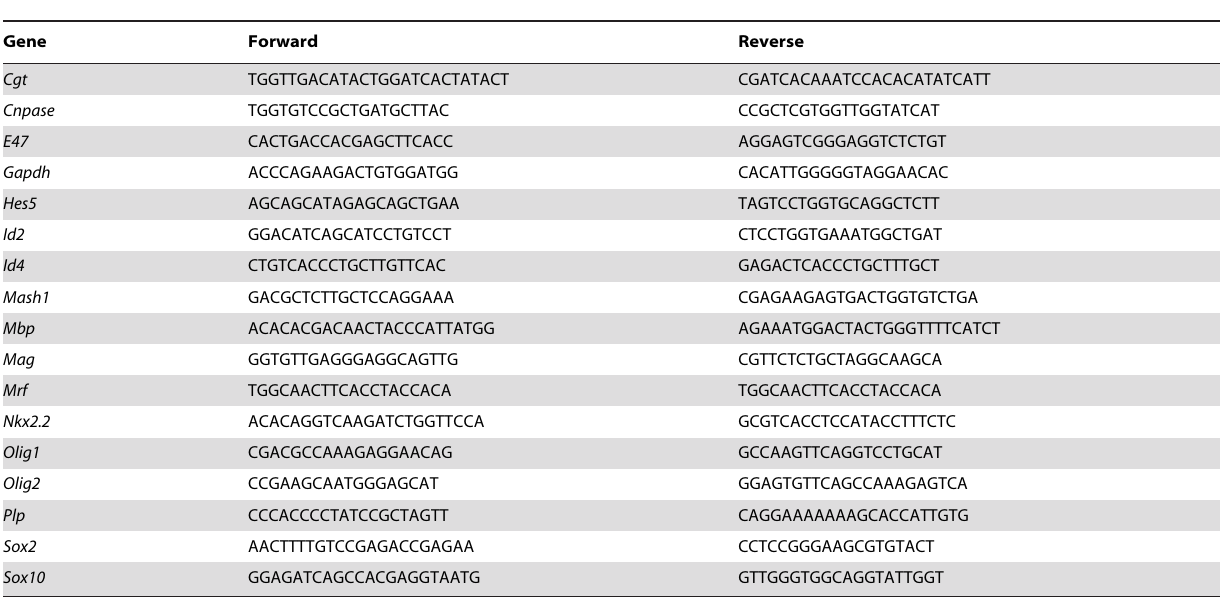
Table 1. Primers used in quantitative PCR for amplification of mouse gene